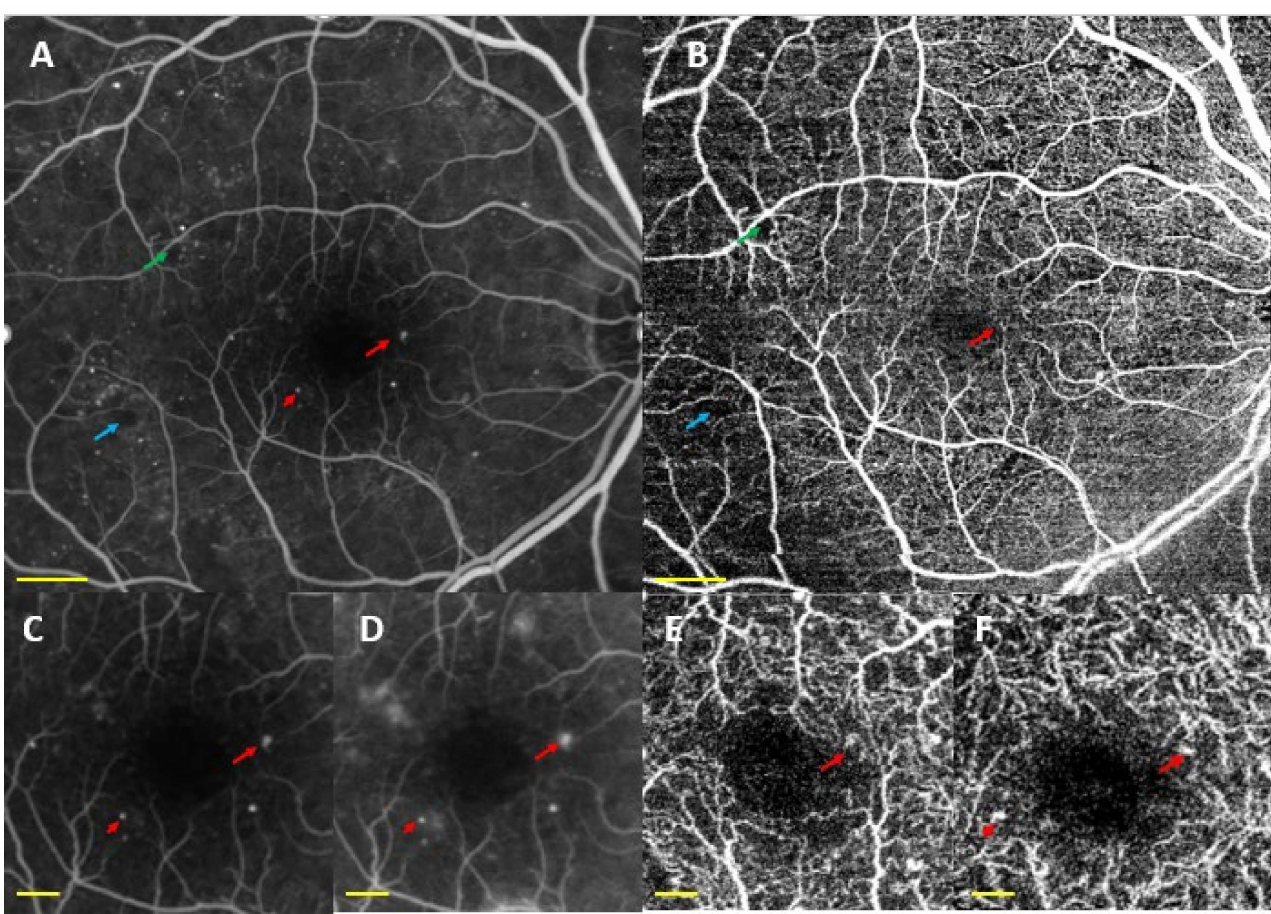
Figure 5. Fluorescein angiography (FA) ( A , C , D ) vs. swept source optical coherence tomography angiography (SS-OCTA) ( B , E , F ) showing microaneurysms (MAs) (red arrow and arrowhead) in diabetic patients. ( A , C , D ) MAs in the superficial and deep capillary plexuses (SCP and DCP) and nonperfusion areas (green and blue arrows) detected by ( A , B , E , F ) show the same MAs in SCP ( E ), DCP ( F ), and nonperfusion areas ( B ), visualised by OCTA. FA was acquired using a Spectralis-HRA (Heidelberg Engineering, Heidelberg, Germany). ( A , C ) Arterial time in the FA and ( D ) tissue times. OCTA was acquired with DRI-Triton SS-OCT (Topcon, Tokyo, Japan). ( B ) 9 × 9 mm OCTA and ( E , F ) 3 × 3 mm OCTA of both SCP and DCP, respectively. Scale bar (in yellow) represents 1 mm in Figure 5A,B and 250 microns in Figure